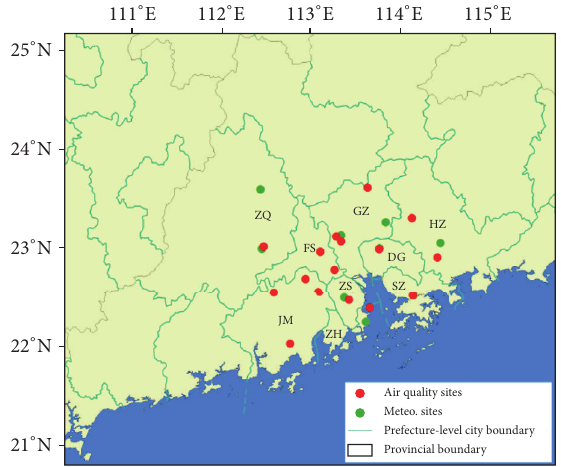
Figure 1: WRF-Chem domain setting and locations of the obser- vation sites. GZ: Guangzhou, FS: Foshan, SZ: Shenzhen, DG: Dongguan, ZS: Zhongshan, ZQ: Zhaoqing, HZ: Huizhou, ZH: Zhuhai, and JM: